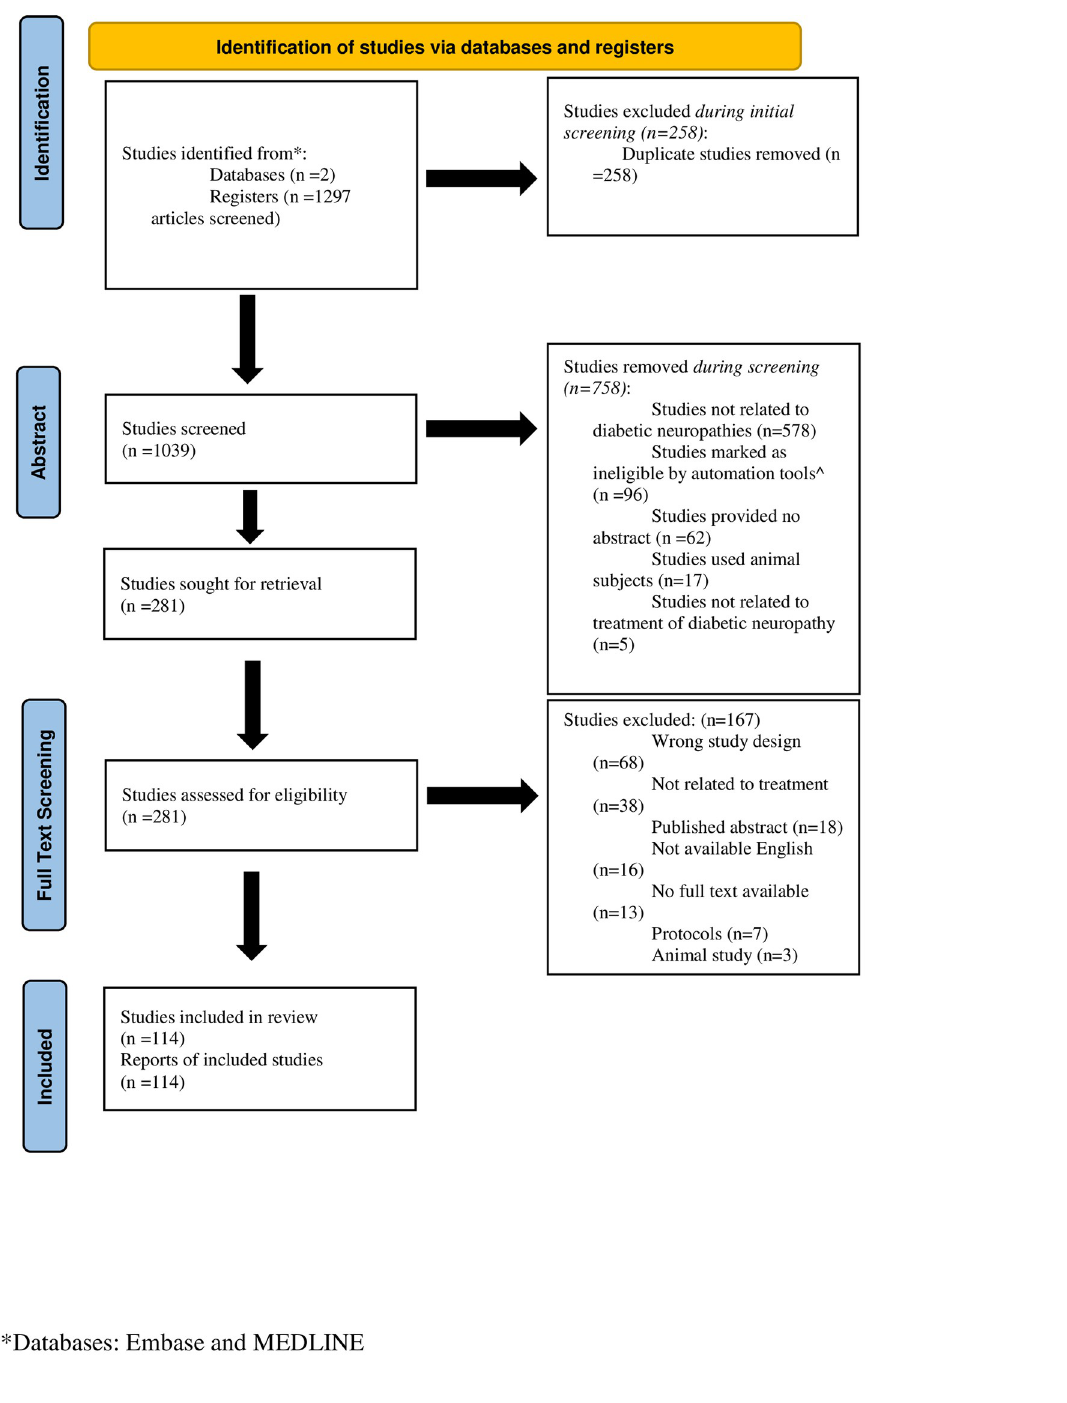
Fig 2. Flow diagram of study